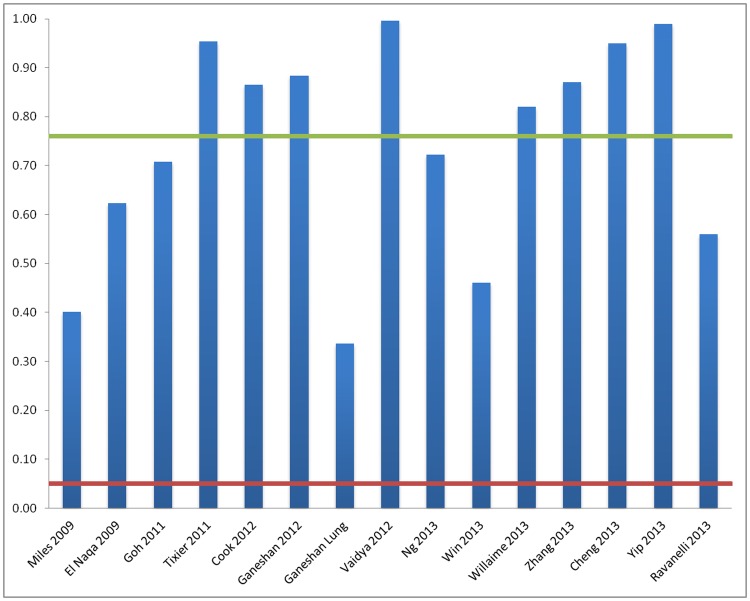
Probability of a false positive result based on number of hypotheses tested per study (blue columns) for all study categories.5% type-I error probability = red line, average type-I error probability (76%) over all studies = green line (Note—additional inflation of the type-I error probability due to the use of the optimum cut-off approach is not included here).